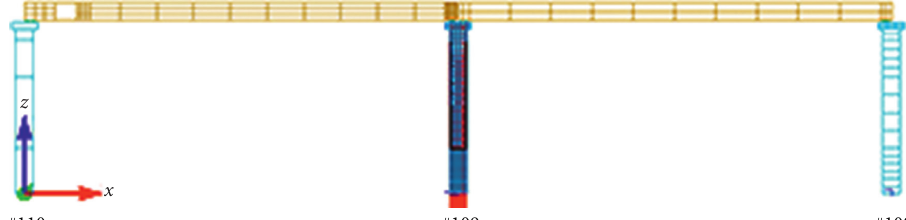
Figure 4: Mesh details of two spans of Hongqi Bridge in